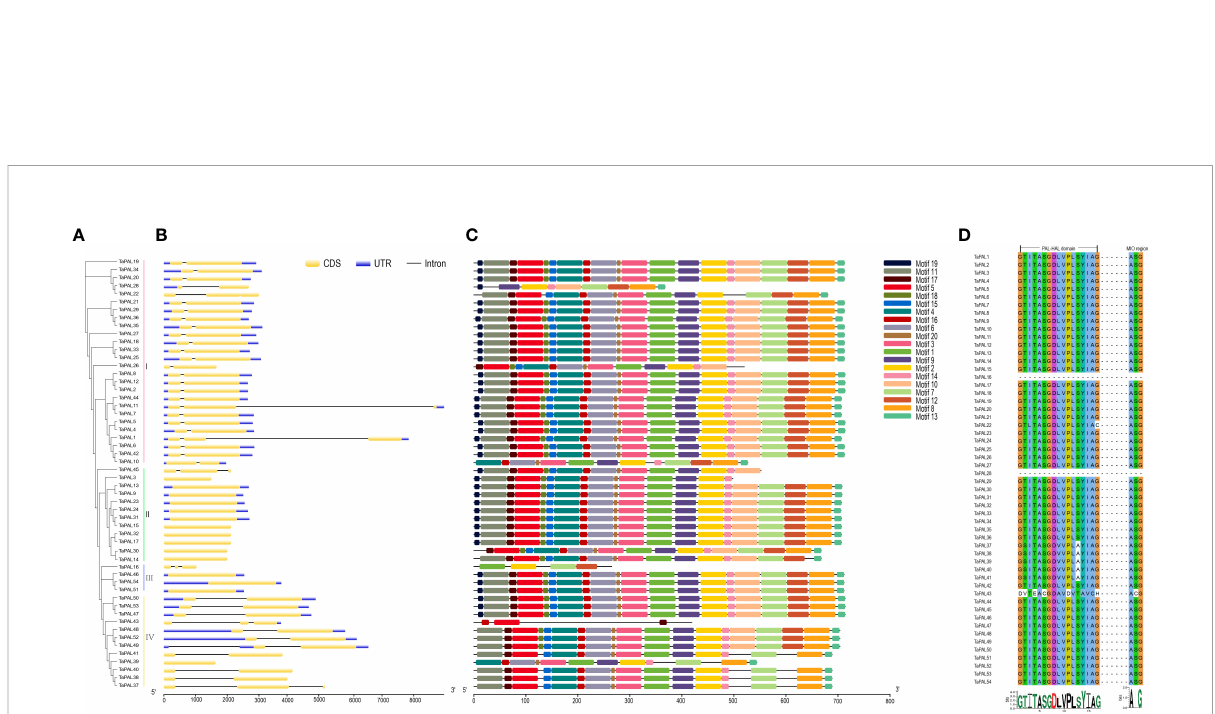
FIGURE 2 Phylogenetic analysis, gene structure, conserved motifs and sequence alignment of PAL domains of TaPALs. (A) The phylogenetic tree of all PAL genes in common wheat. The tree was created with bootstrap of 1000 by maximum likelihood (ML) method in MEGA7. (B) The exon-intron structure of PAL genes in common wheat. (C) The motif compositions of TaPAL were identi fi ed by MEME. Model exhibition of motif compositions in PAL amino acid sequences using MAST. (D) Multiple sequence alignment of PAL domains in identi fi ed wheat PAL